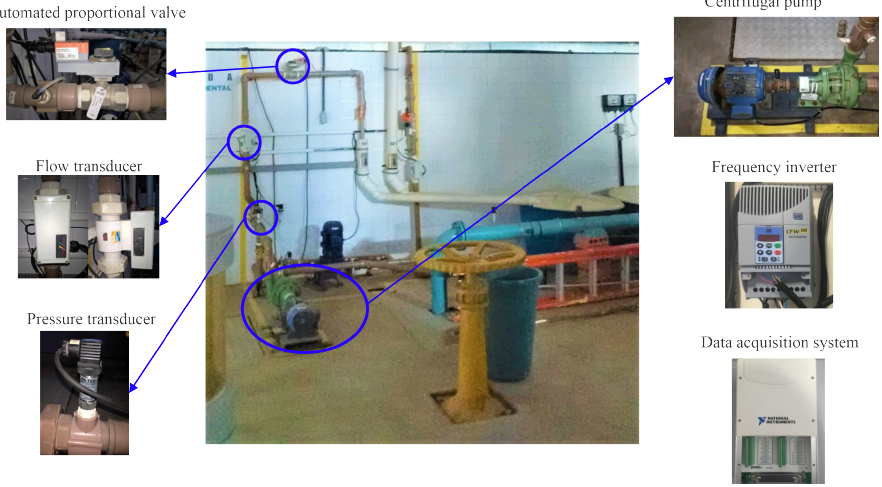
Figure 1. Photograph of the experimental